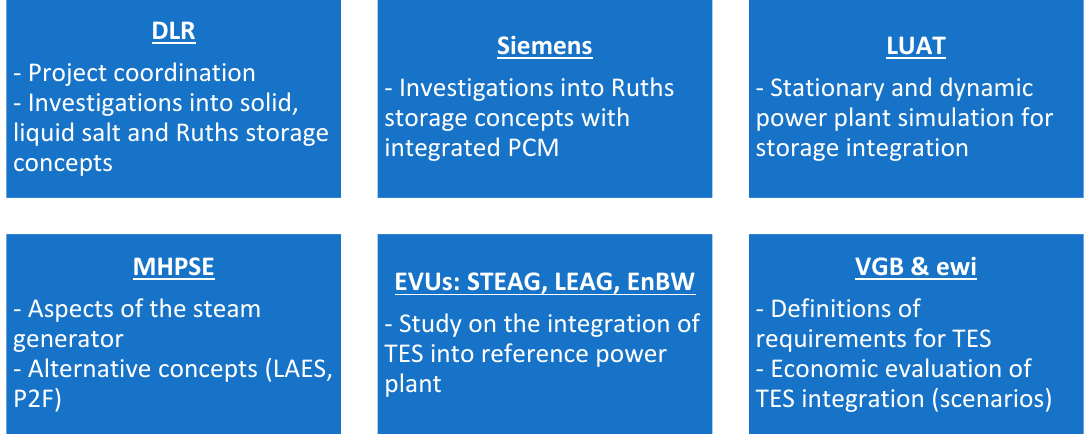
Figure 1. Project partners and work contents in the joint project FLEXI- TES.